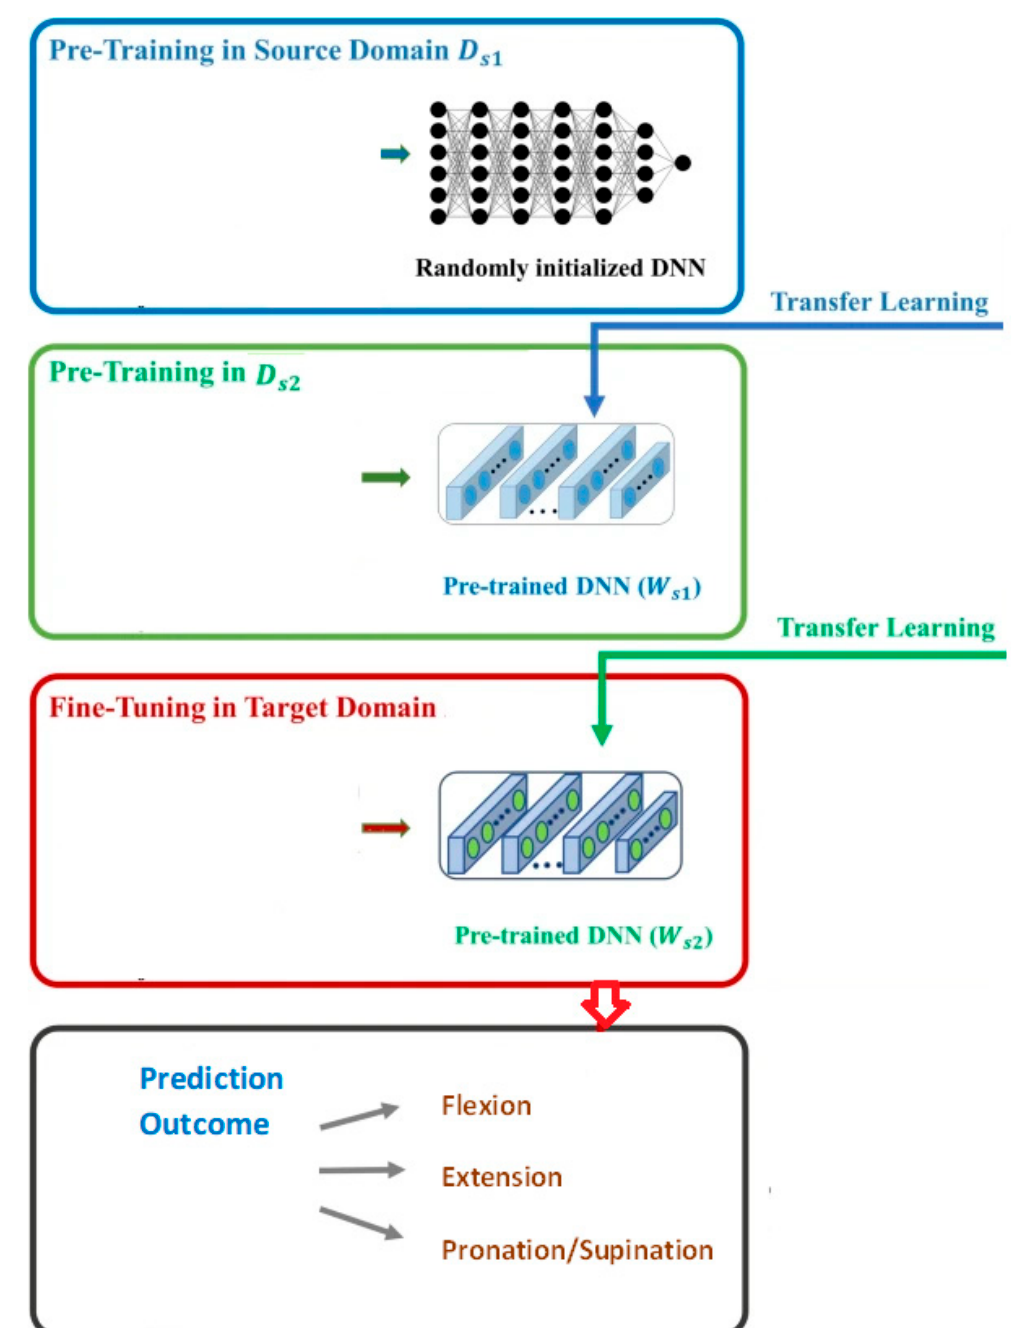
Figure 3. Methodology to obtain deep learning models for transfer learning (the flow diagram of the BSM-EEG model).